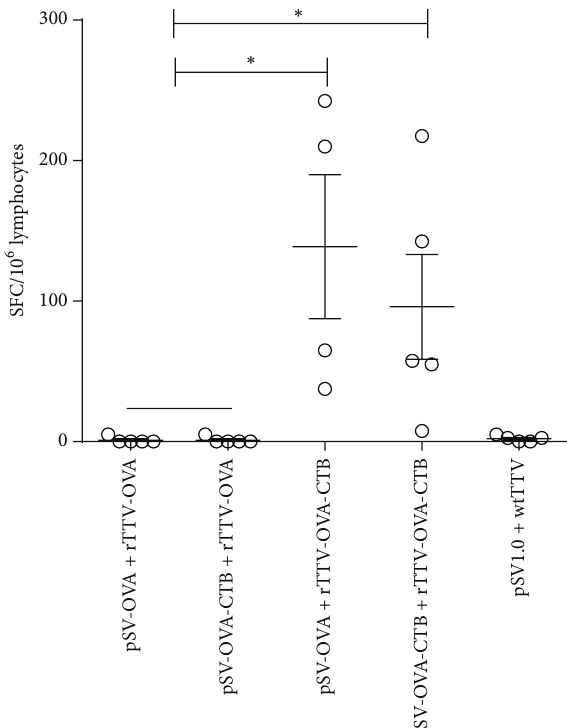
Figure 4: T-cell responses elicited in mesenteric lymph node. rTTV-OVA-CTB boosting raised significantly more rigorous T-cell responses than rTTV-OVA boosting groups. ∗ 𝑃 < 0.05